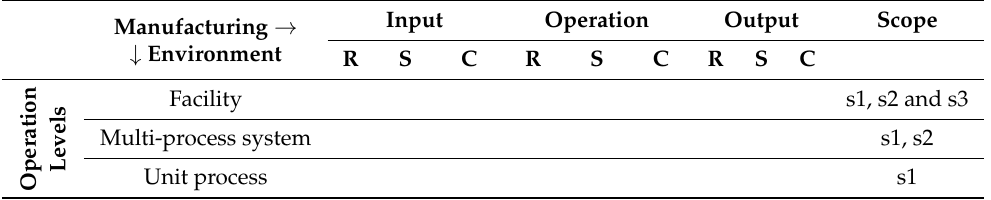
Table 2. KPIs categorisation overview (R: reduction, S: substitution, C: compensation, s: